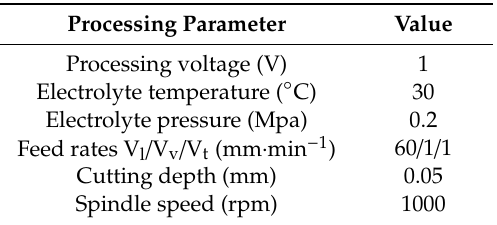
Figure 8. Finishing in the ECMG: ( a ) finishing of groove bottom, ( b ) finishing of groove sidewall. Table 3. Process parameters of the finish-machining test.